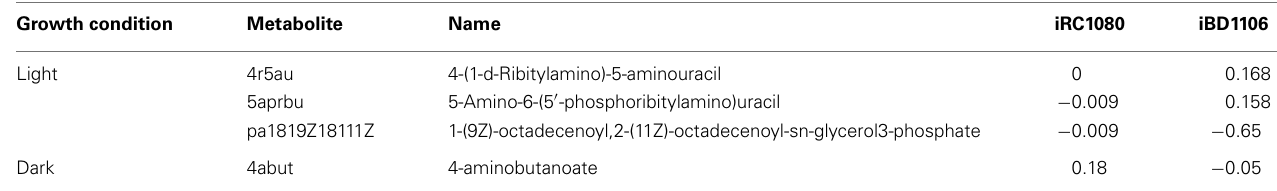
Table 4 | Examples of significant shadow prices for iRC1080 and iBD1106